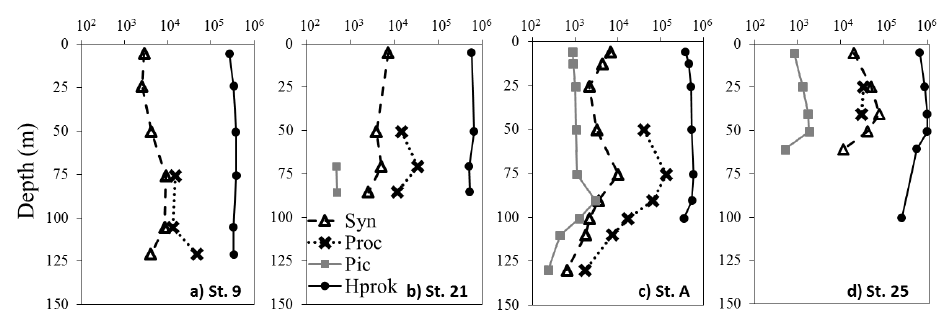
Figure 3. Abundances of Synechococcus (Syn), Prochlorococcus (Proc), picophytoeukaryotes (Pic) and heterotrophic prokaryotes (Hprok) at the depths of sorted experiments at stations 9, 21, A and 25.